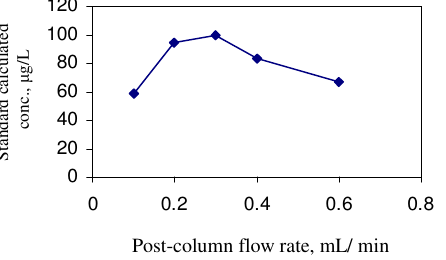
Figure 2. Plot of bromate conc. against the PCR flow rate chromatographic conditions are listed under experimental